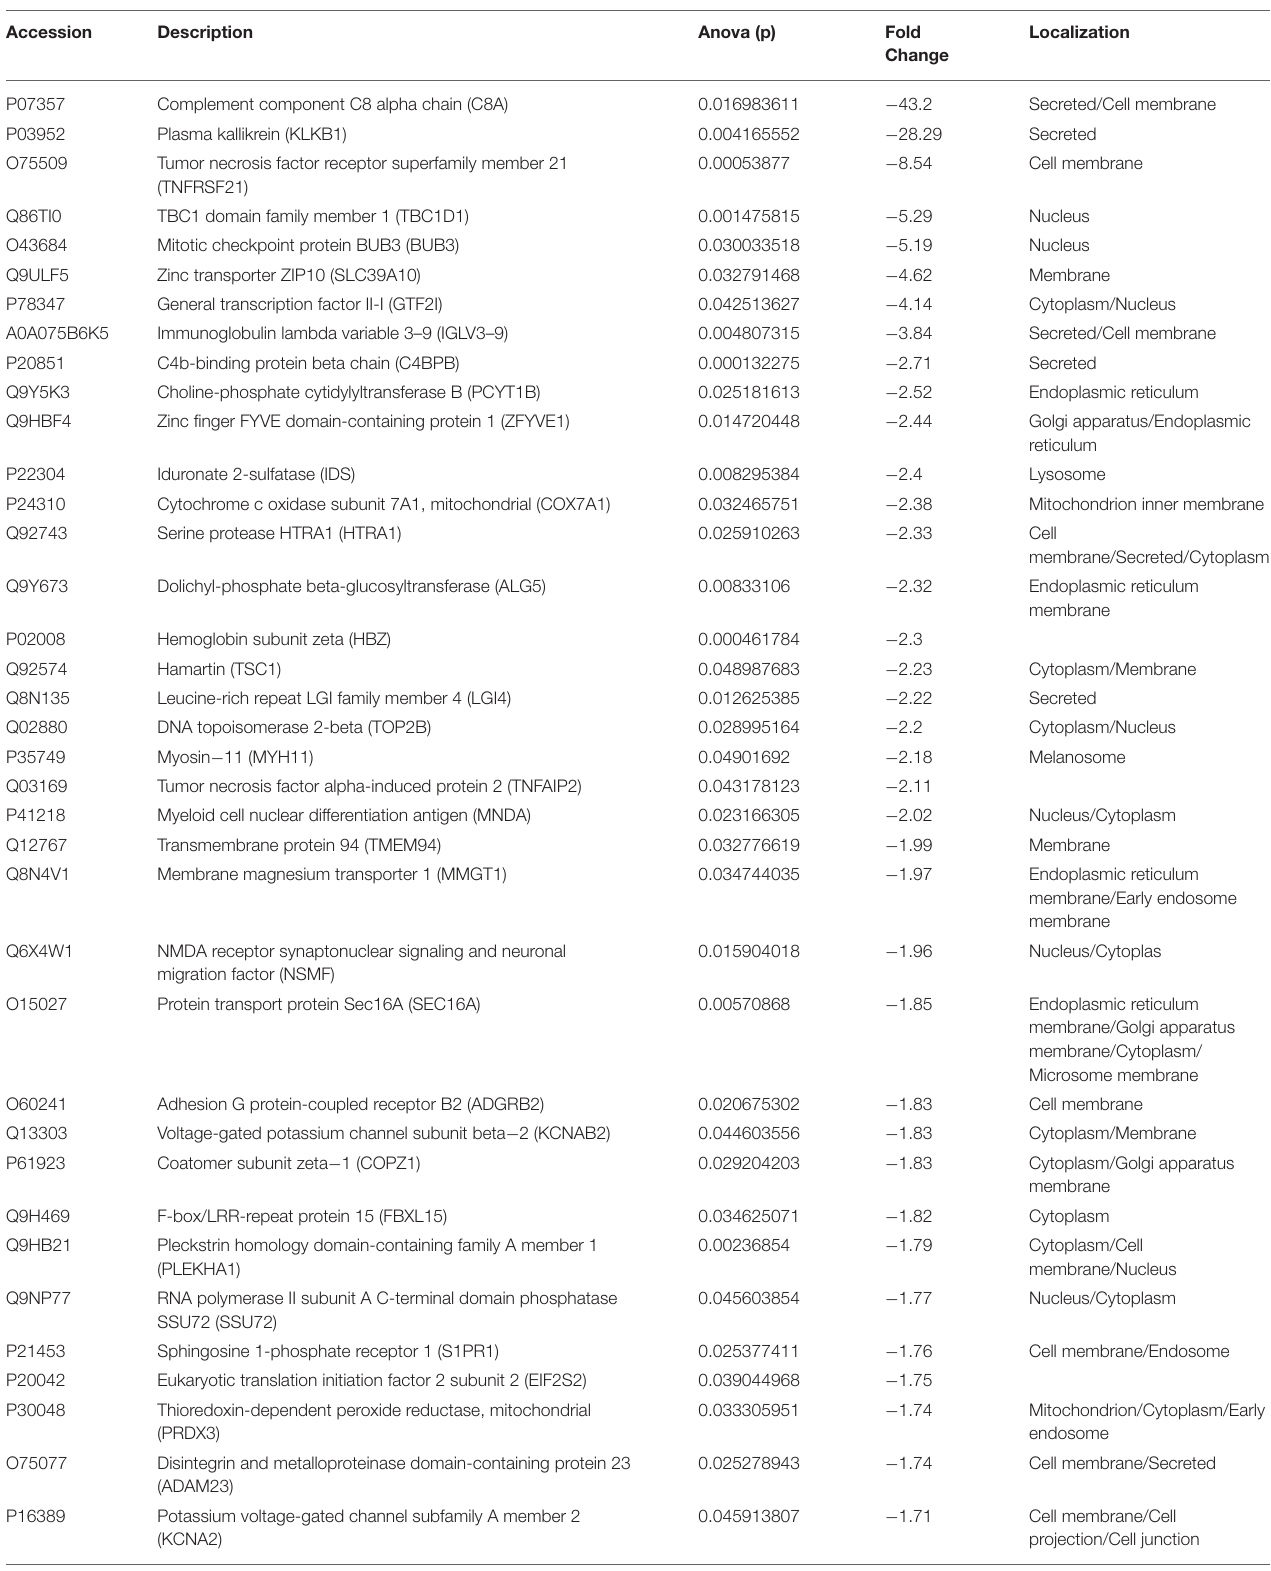
TABLE 3 | Differentially expressed proteins in the TSC1 truncating mutation group and the control